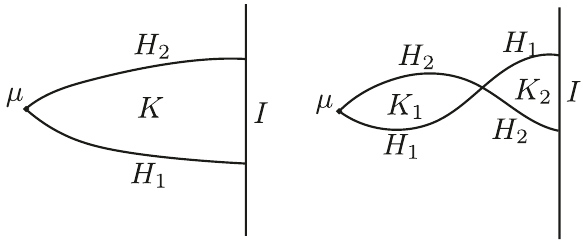
Figure 7 . Illustration of two homology slices, which by the lack of evaporating singularities, must have the same outer